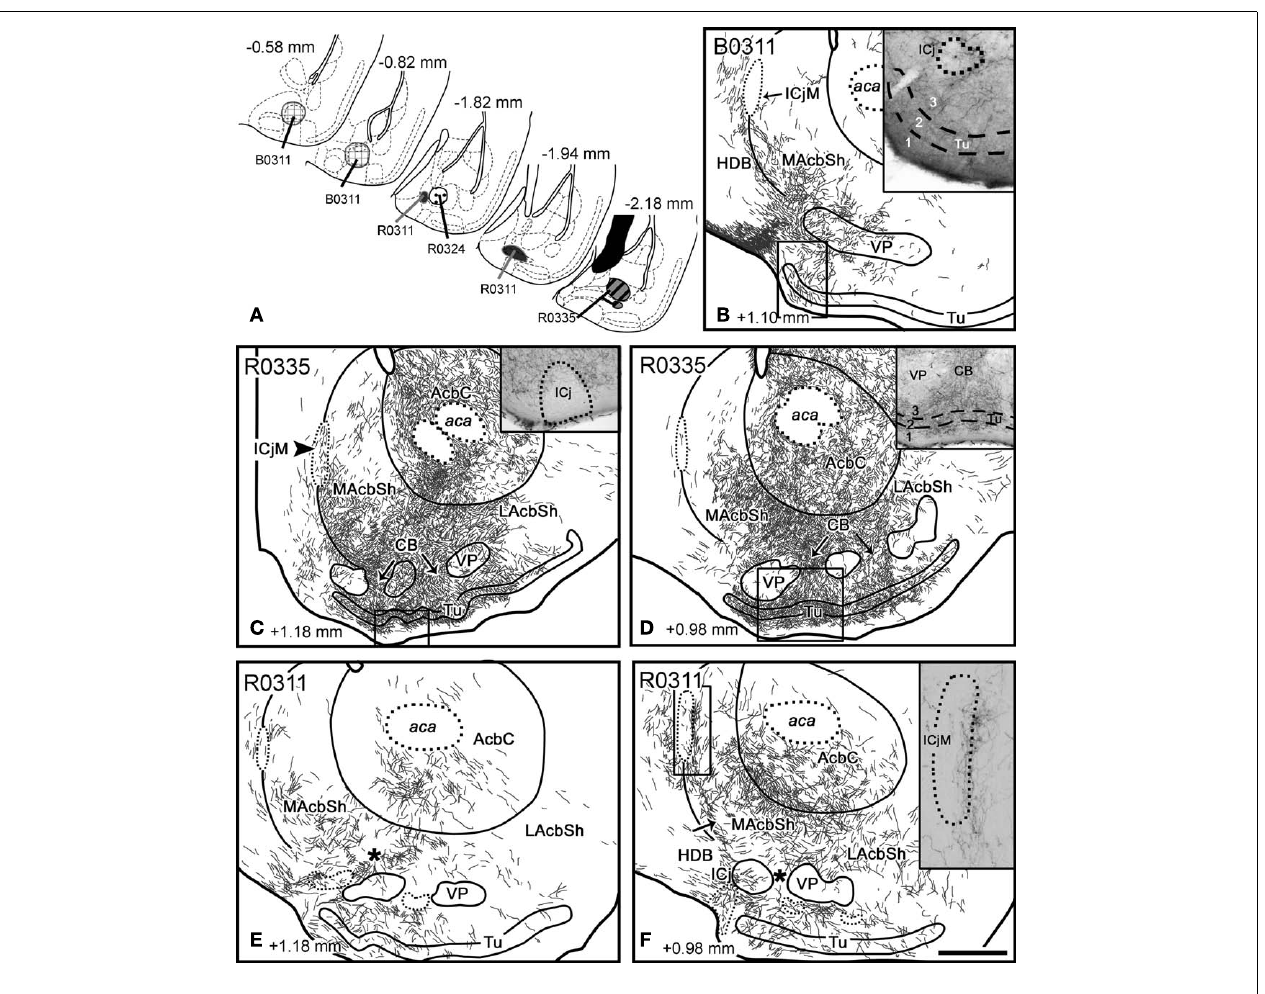
(especially in the LAcbSh), a labeled terminal field is found next to some of the ICj [inset in (C) ] and in the ICjM [arrowhead in (C) ]. In theTu, anterograde labeling is found in layers 2 and 3 and in deep layer 1 [inset in (D) ]. (E,F) Anterograde labeling in the ventral striatum after an RDA injection restricted to the lateral AHA (R0311) (no counterstaining). Moderately dense labeling occupies the ventral core as well as parts of the medial and lateral shell of the Acb. Scattered labeled fibers are also found in the neighboring CB (asterisks) and in theTu. In addition, conspicuous terminal fields are found in the medial ICj and, especially, next to the ICjM [see inset in (F) ]. For abbreviations, see list. Scale bar in (F) = 400 μ m, valid for the